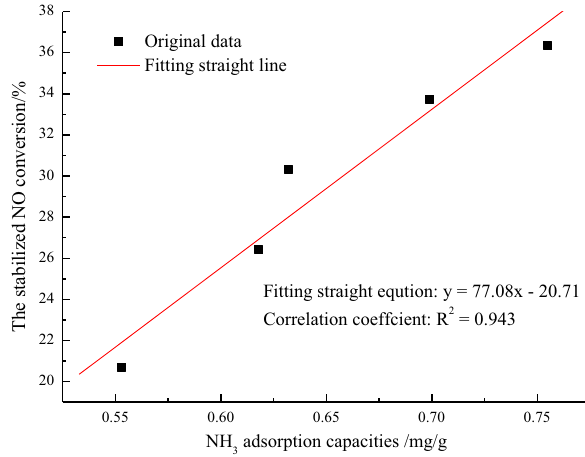
Fig. 7 Relationship between stabilized NO conversions and NH 3 adsorption capacities by the